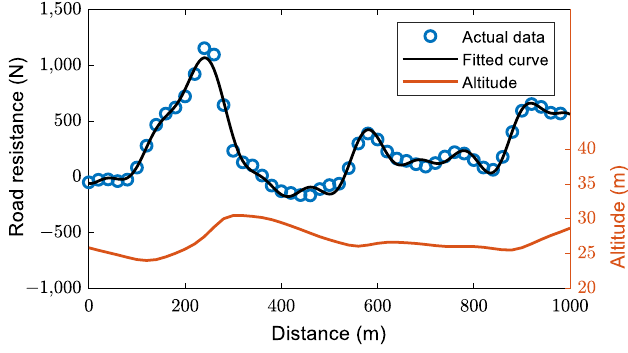
Figure 8. Road resistance along the distance.